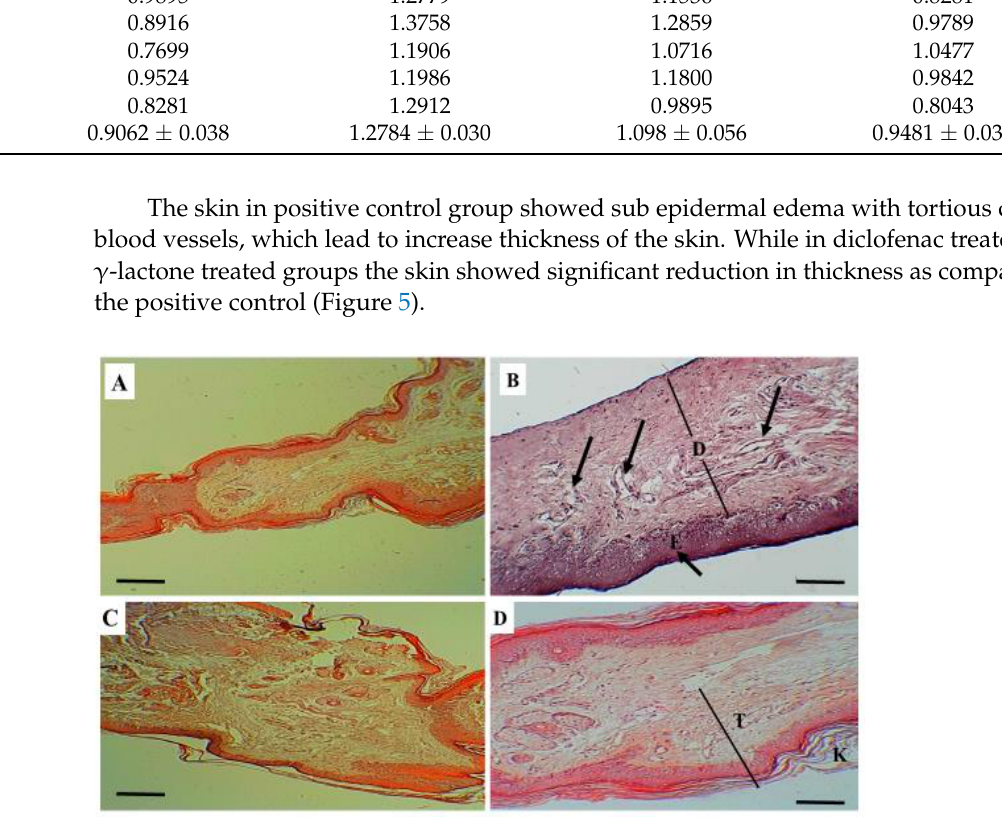
Figure 5. The histopathological assessment of skin thickness in rats: Photo ( A ): negative control, ( B ):